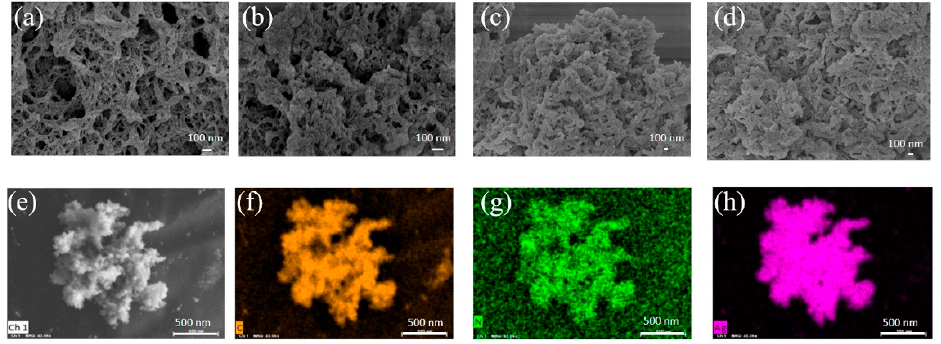
Figure 3. SEM images of: ( a ) NPOP-1, ( b ) Ag@NPOP-1, ( c ) NPOP-2, and ( d ) Ag@NPOP-2. The EDS elemental mappings of: ( e ) Ag@NPOP-1, ( f ) C, ( g ) N, and ( h ) Ag.